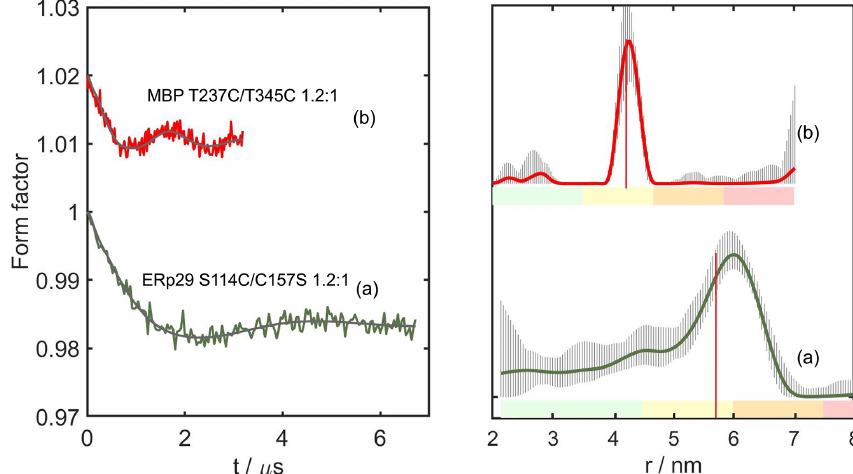
Figure 5. DEER distance measurements with DCP-( β -Cys) 2 -Gd tags. As in Fig. 4, the left and right panels show the form factors after background subtraction and the distance distribution calculated by DeerAnalysis2018 (Jeschke et al., 2006). All samples were recorded with 1 . 2 : 1 Gd 3 + ion-to-tag ratio. (a) ERp29 S114C/C157S. (b) MBP T237C/T345C. The vertical red lines indicate the maxima of the modelled distance distributions predicted with the program PyParaTools (Fig. S15; Stanton-Cook et al., 2014). The uncertainties in the distance distributions and ranges of alternative distributions are indicated as in Fig. 4. The primary DEER data are shown in Fig. S11, and the distance analysis of (b) by DeerNet (Worswick et al., 2018) is given in Fig.